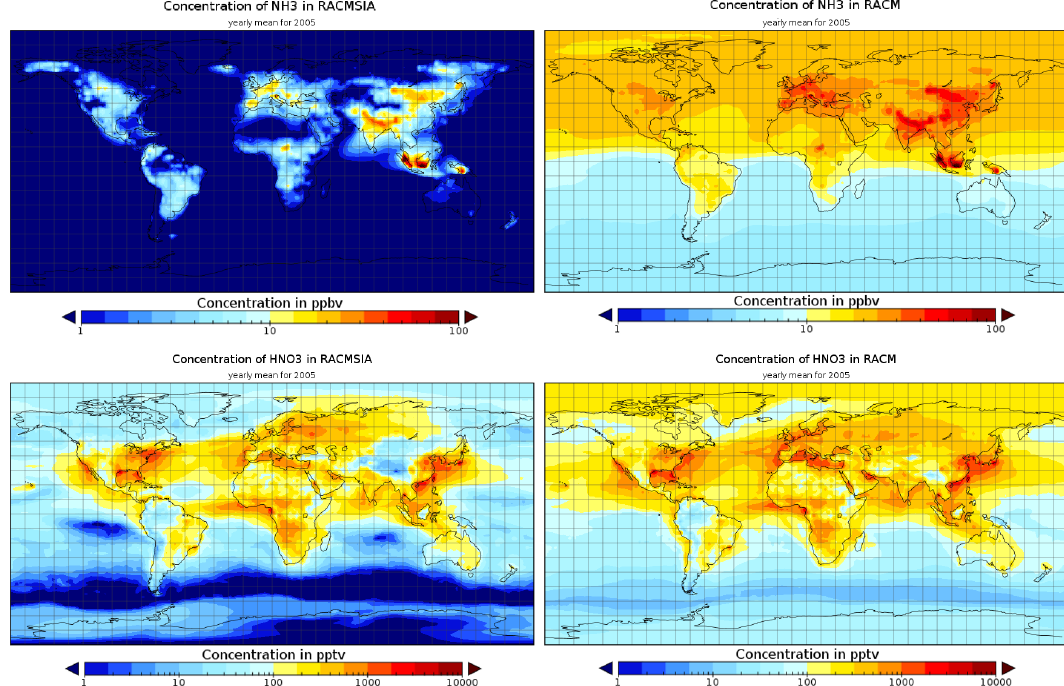
Figure 5. Maps of global annual mean concentrations of NH 3 in ppbv (top panels) and HNO 3 in pptv (bottom panels) for both simulations: RACMSIA (left side) and RACM (right